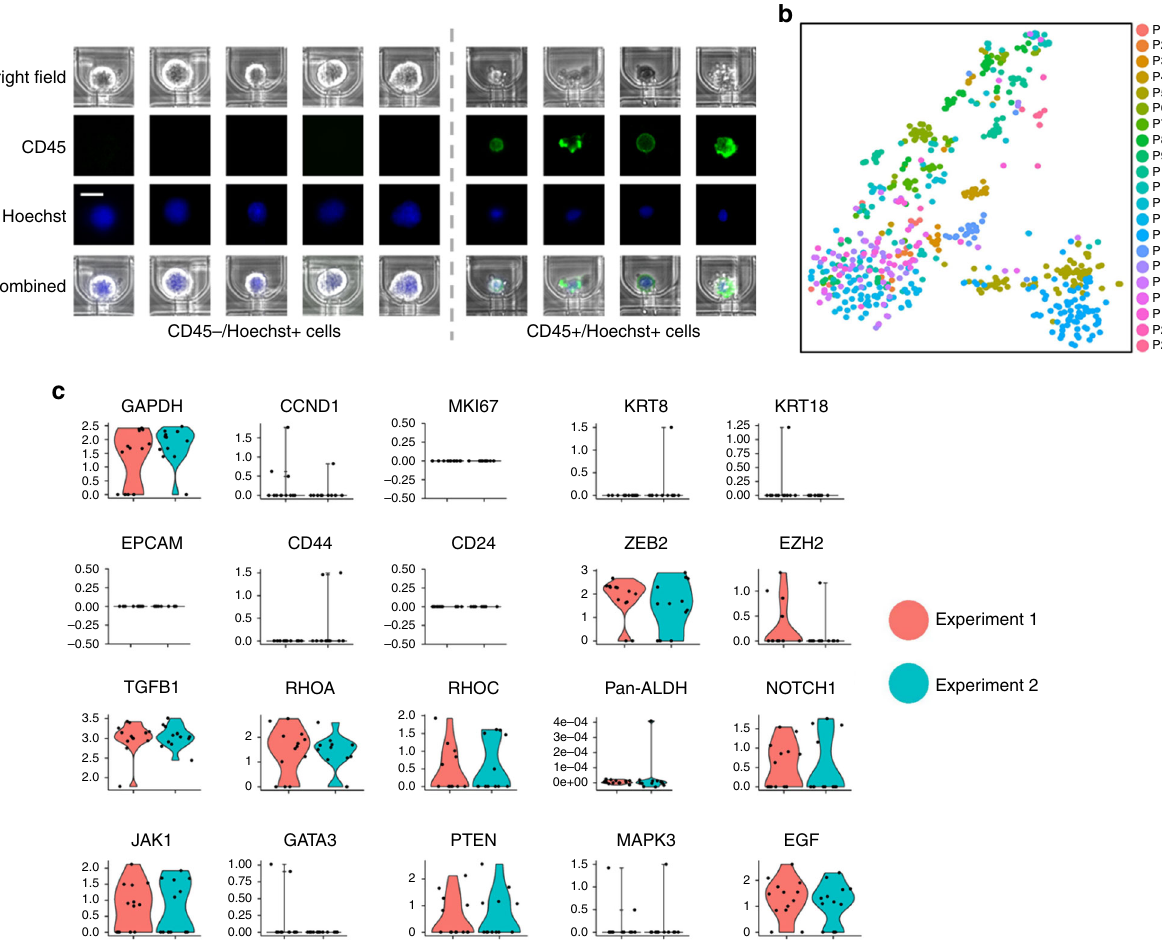
Fig. 3 Immunostaining and single-cell RNA-sequencing of CTCs. a With CD45 and Hoechst staining, the CD45 positive nucleated cells were identi fi ed as leukocytes. (Scale bar: 15 µ m) b tSNE plot of all CTCs from patient samples processed by Hydro-Seq. (666 CTCs from 21 patient samples with each color representing individual patient sample.) c The reproducibility test of Hydro-Seq processing. For the two tubes of blood drawn from the same patient and processed on the same day, comparable CTC counts were achieved from the two experiments (Exp. 1: 13 CTCs with red color; Exp. 2: 12 CTCs with cyan color). The expression pro fi les of housekeeping, cell proliferation, epithelial, mesenchymal, and other genes are consistent, showing good reproducibility. Source data are provided as a Source Data fi